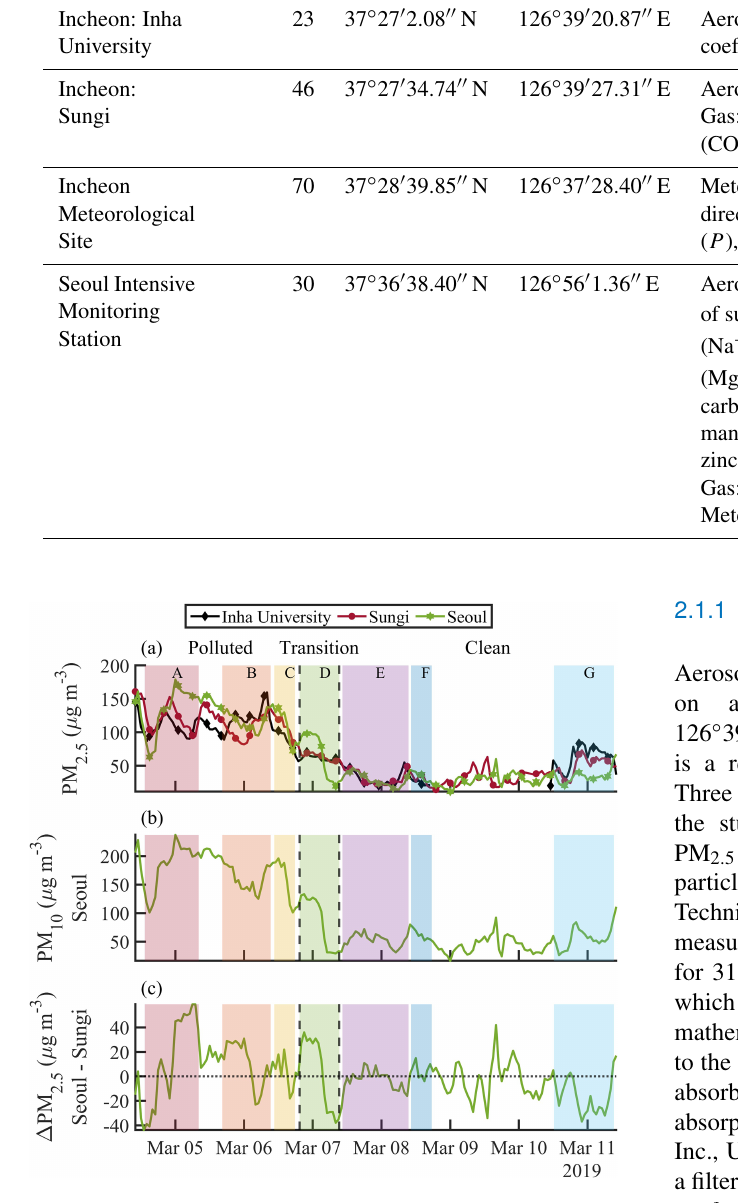
Figure 2. Time series of the following parameters: (a) PM 2 . 5 mea- sured at Inha University, Sungi, and Seoul; (b) PM 10 measured at Seoul; and (c) PM 2 . 5 difference between Seoul and Sungi. The dashed black vertical lines separate the (left) polluted, (middle) transition, and (right) clean periods. The horizontal line in (c) de- notes a PM 2 . 5 difference of zero to clearly show positive and neg- ative deviations from that value. Shaded regions are labeled with individual DLPI + sets (see Table 2) overlapping in